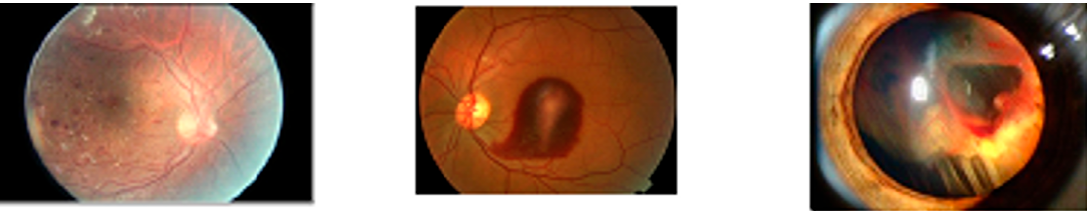
Figure 2. Neovascularisation ( left ), preretinal hemorrhage ( middle ), and retinal detachment ( right ) [20–22].